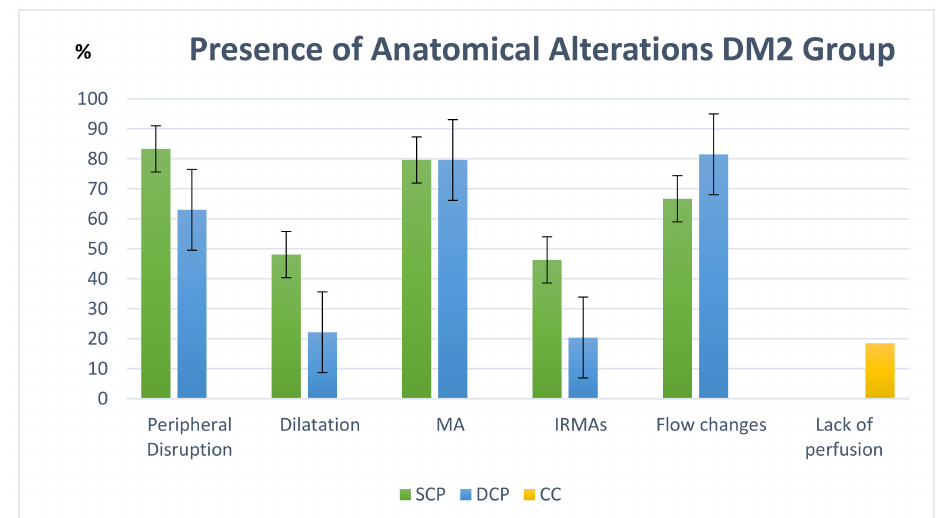
Figure 3. Qualitative analysis of the alterations presented in the type 2 diabetes mellitus (DM2) group in percentage (%). Abbreviations: SCP, superficial capillary plexus; MA, microaneurysms; IRMAs, intraretinal microvascular abnormalities; DCP, deep capillary plexus; CC, choriocapillaris.